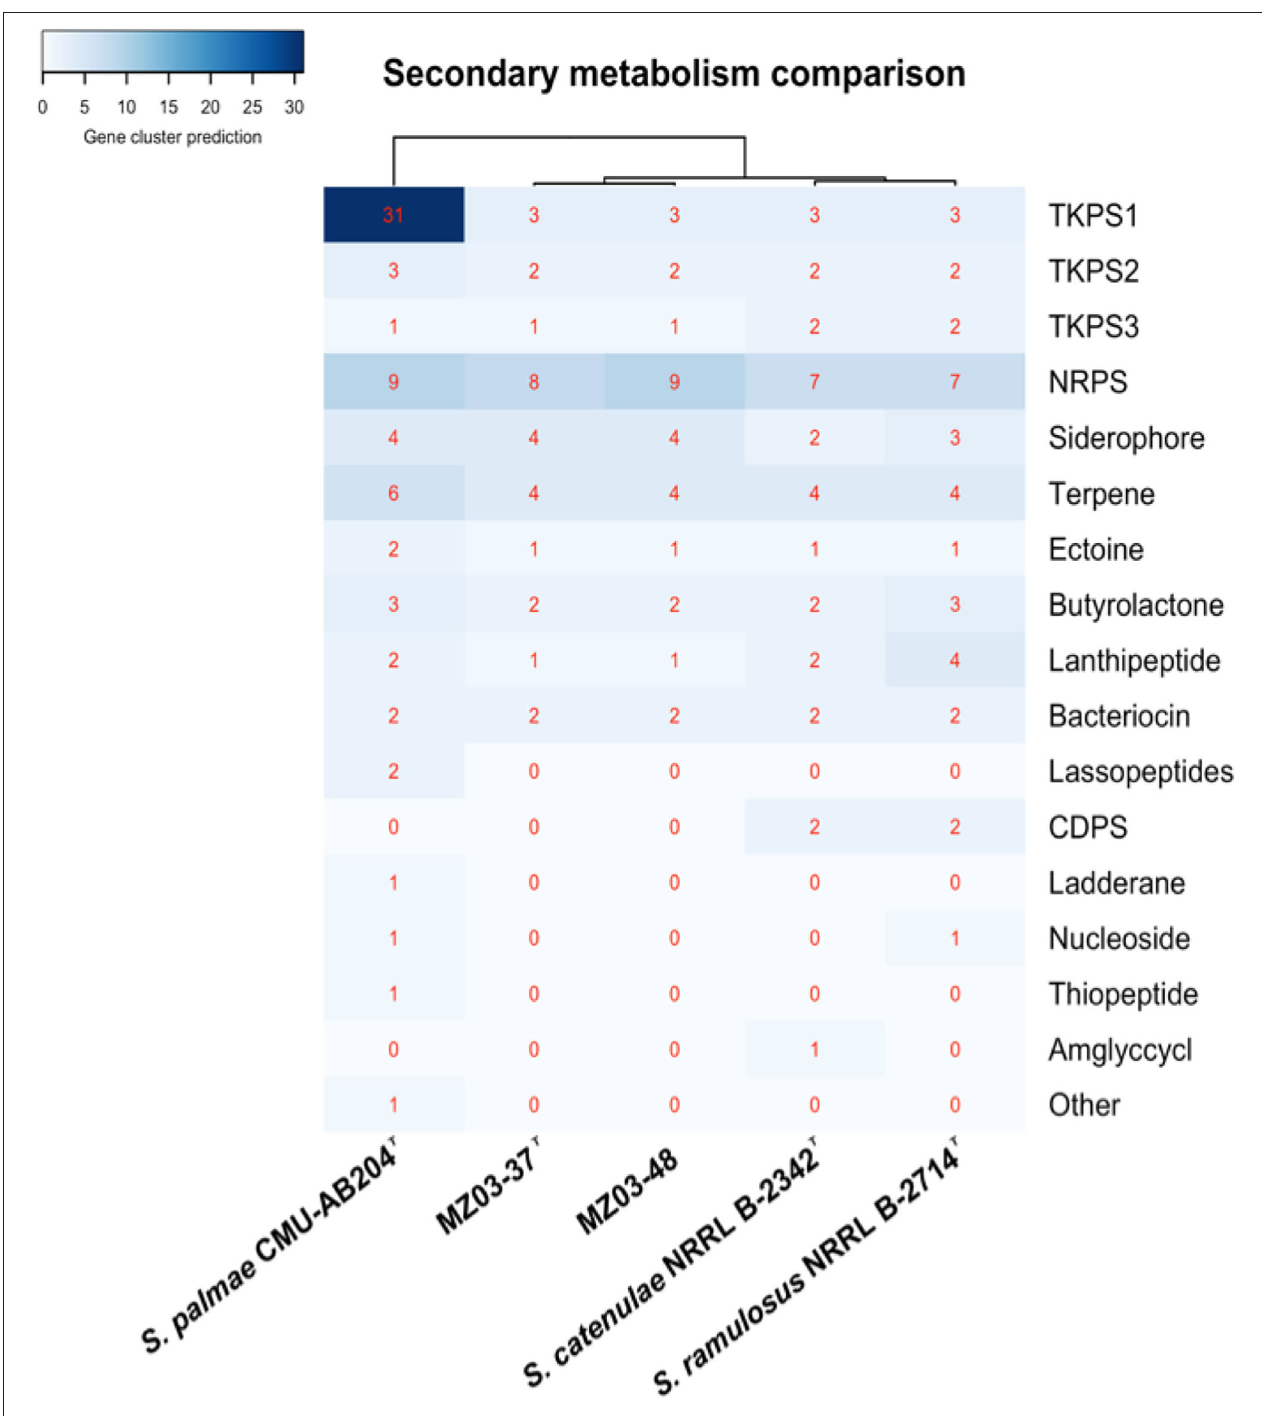
FIGURE 2 | Secondary metabolism comparison using anti-SMASH. Abundance of secondary metabolites predicted. TKPS1, type 1 polyketides synthase; TKPS2, type 2 polyketides synthase; TKPS3, type 3 polyketides synthase; NRPS, nonribosomal peptide synthase; CDPS, tRNA-dependent cyclodipeptide synthase; Amglyccycl, aminoglycoside/aminocyclitol cluster; other, cluster containing a secondary metabolite-related protein that does not fit into any other category. Cladogram built using Euclidean algorithm.